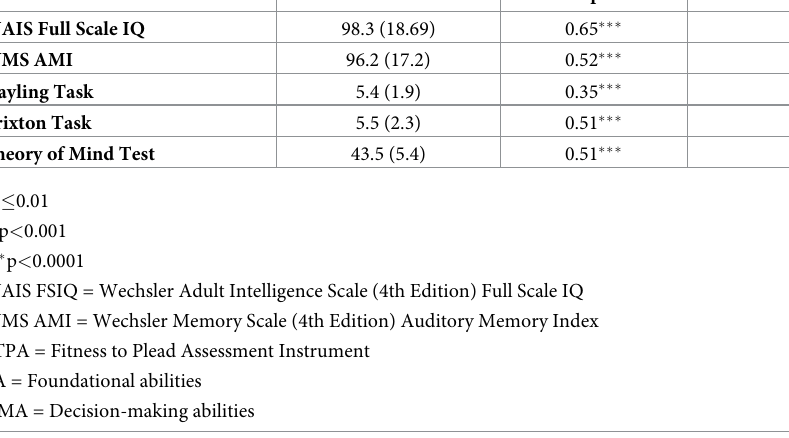
Table 4. Score distributions and pearson’s correlations of cognitive and executive function tests with FTPA-instrument total and subscale scores. Score Mean